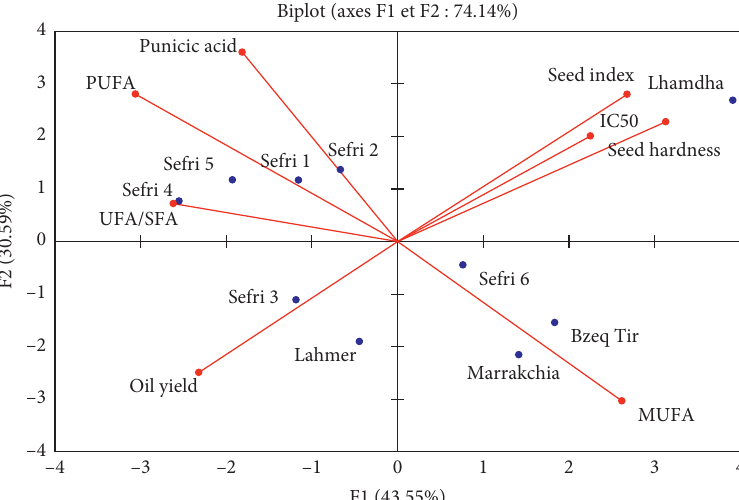
Figure 1: Principal component analysis (PCA) of the first two components (F1 and F2): segregation of ten Moroccan pomegranate cultivars based on the physicochemical and biochemical characteristics of their seeds and seed oils (SFA: saturated fatty acid; UFA: unsaturated fatty acid; MUFA: monounsaturated fatty acid; PUFA: polyunsaturated fatty acid).